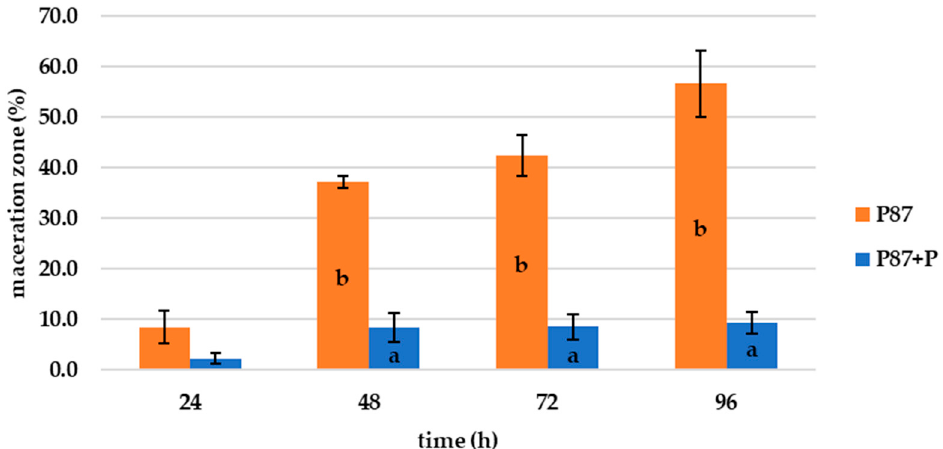
Figure 2. Maceration zones (%) of P87 bacterial rot during 96 h at 25 °C; +P–phage treated; columns represent the means, and the error bars represent the standard deviations; means with different lowercase letters (a or b) are significantly different between the control and phage-treated samples ( p < 0.05).